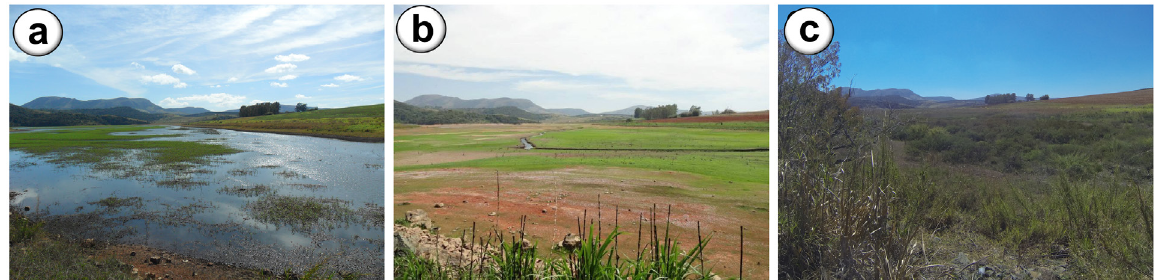
Figure 2. Variation of the water column in sampling site at Furnas HPS reservoir (Sapucaí River, state of Minas Gerais). a. 2011 - Flooded area (typical pattern). b. 2012 - Exposed area due to a severe drought. c. 2014 - Terrestrial succession after two years of the massive mortality of Anodontites trapesialis . a-b. Modified from Paschoal et al.